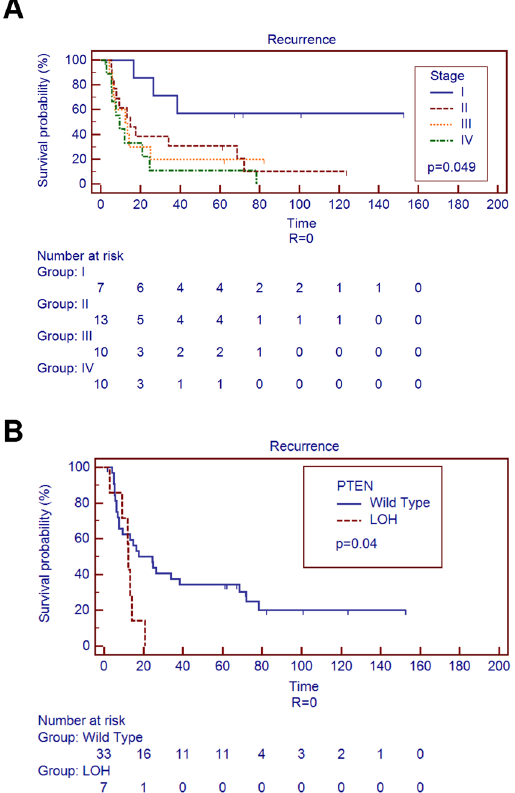
Figure 4. Univariate analysis identified markers of disease recurrence in negative resection margins cases. ( A ) Disease recurrence is significantly affected by advanced stages and ( B ) LOH of PTEN